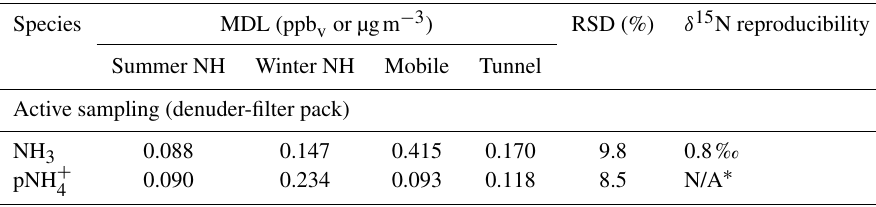
Table 1. Summary of method detection limit (MDL), pooled relative SDs (RSD), and δ 15 N reproducibility of NH 3 determined from active sampling using a denuder-filter pack (ChemComb speciation cartridge). The MDL is reported in units of ppb v for NH 3 and µgm − 3 for pNH + . The MDL is reported for each sampling environment, including the near-highway (NH) monitoring location in Providence, RI, USA, 4 during the summer (Summer-NH) and winter (Winter-NH) on-road mobile measurements in the northeastern USA (Mobile) and the tunnel in Shenyang, Liaoning, China (Tunnel).